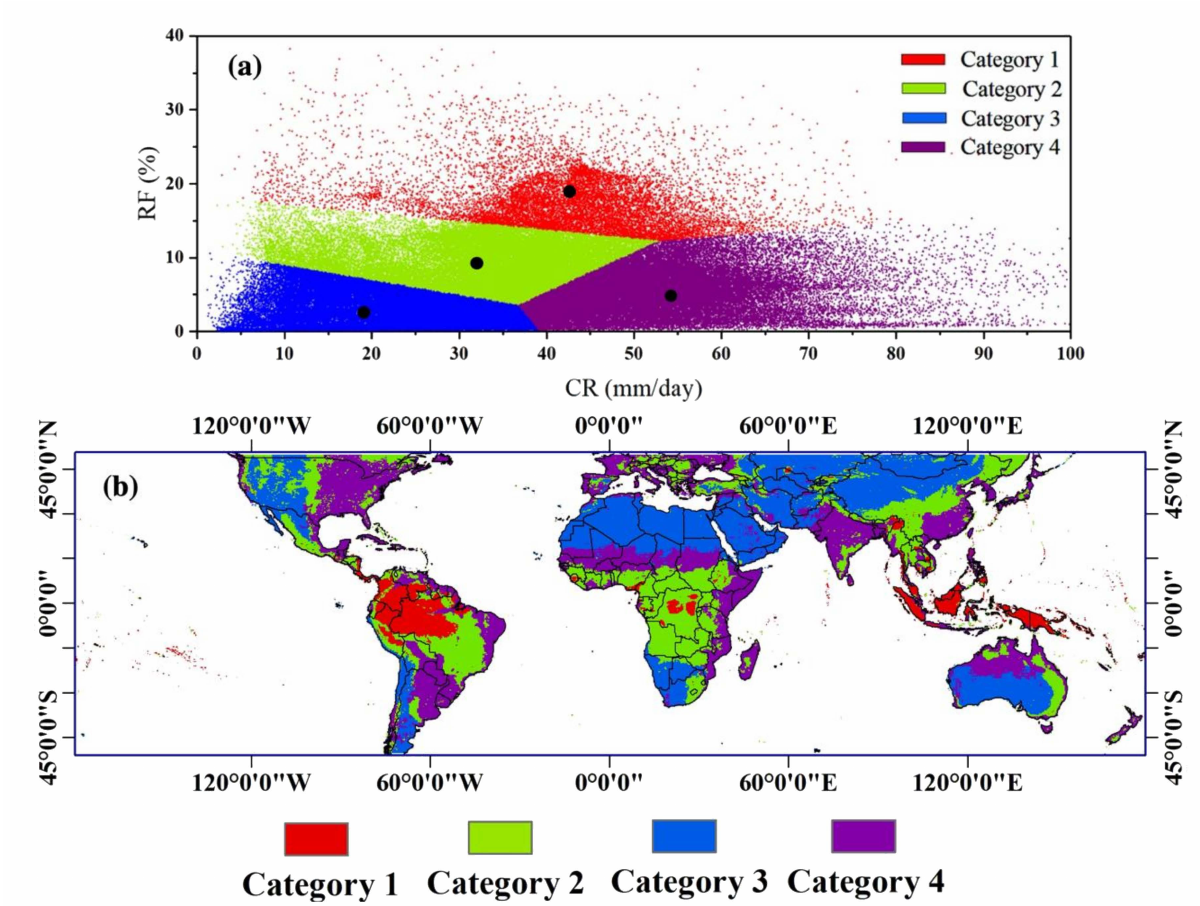
Figure 6. ( a ) K-means clustering based on mean RF and CR for land, black dots are the centroids of each cluster. ( b ) Distri- butions of precipitation categories over